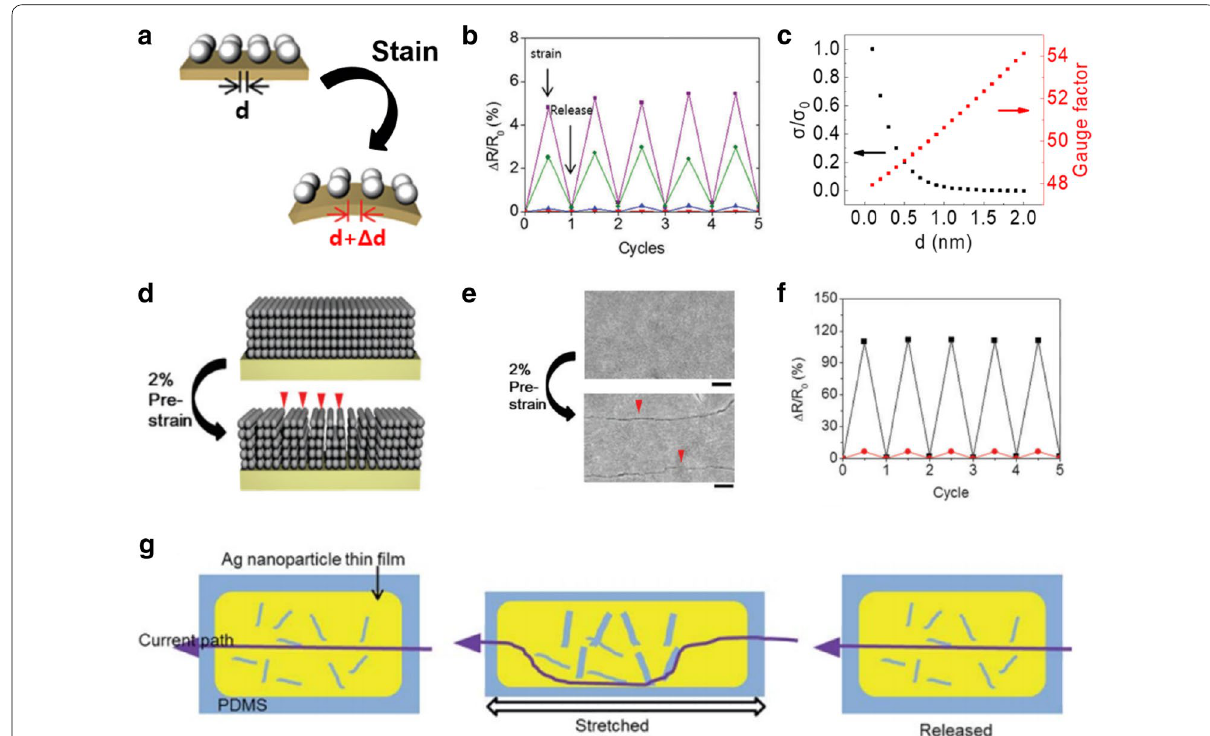
Fig. 2 a Schematic of NC thin films after applied strain. b Cycle tests with application of 0.2% strain on MPA—(purple), EDT—(green), Cl—(red), and Br—(blue) treated Ag NC thin films. c Conductivity and gauge factor of NC thin films as a function of initial interparticle distance. d Schematics of crack formation strategy. e SEM images of Ag NC thin films after crack formation. f Cycle tests with application of 0.2% strain on MPA-treated Ag NC thin films before (red) and after (black) crack formation and g schematic of current path change of Ag NC thin films with cracks after the strain application (Figure reproduced from a , b , and d – f [50], Copyright 2017, Royal Society of Chemistry; c [59], Copyright 2017, Wiley-VCH; g [60] Copyright 2014, Royal Society of